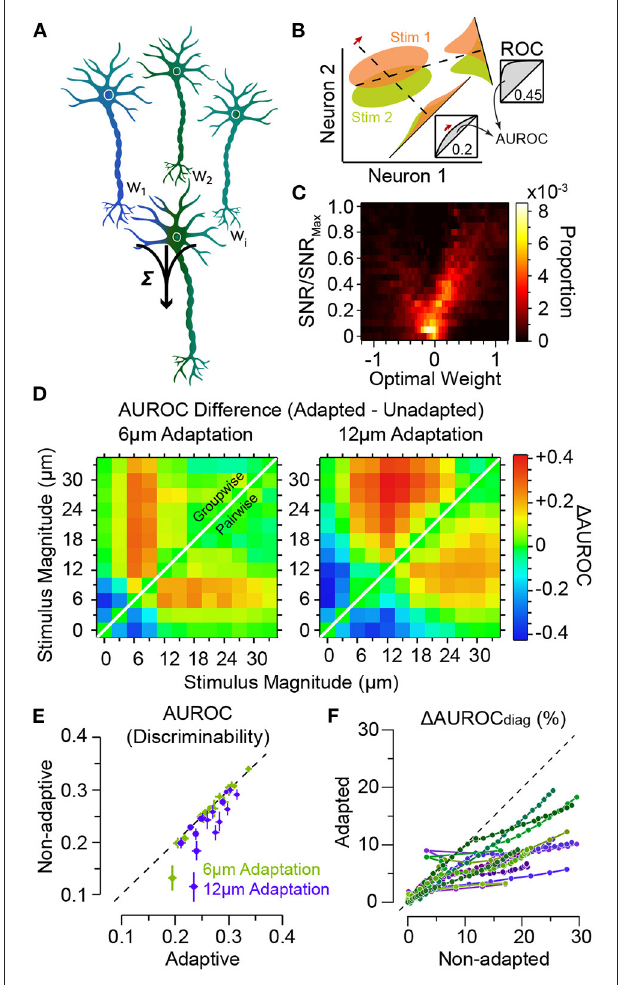
FIGURE 6 | Adaptation improves population decoding. (A) Schematic representation of linear combination of neuronal activity by the downstream decoder. Coefficients w 1 , w 2 and w i represent the synaptic weights between the neurons (top row) and the decoder (bottom). (B) Schematic representation of pooling (summation along identity line) and optimal decoding. The green and orange ovals represent the joint distribution of the neurons’ responses to two sensory stimuli. The solid black lines represent the weight vectors. The weight vector corresponding to pooling is along the identity line. The bell-shaped areas on each weight vector represent the projection of the neuronal response distribution for each stimulus on the weight vector. Dashed lines correspond to the best criterion to discriminate the two stimuli. The insets show the hit rate versus false alarm rate (ROC) for every possible criterion. Grey shaded areas indicate area under ROC (AUROC) quantifying discriminability. (C) The optimal decoding weights for informative neurons are higher. Histogram of the optimal weights as a function of the signal-to-noise ratio (SNR) for each stimulus pair across populations of 8 single neurons. The weights and SNR values are normalised to that of the best neuron in each population. (D) Shift in discriminability from low amplitudes to amplitudes higher than the adapting stimulus for every stimulus pair, in a sample session with 11 simultaneously recorded single neurons. Left and right panels exhibit the difference in discriminability (in terms of AUROC) between adapted and non-adapted conditions. Pairwise decoding applies a distinct set of weights for every stimulus pair, while the groupwise decoding applies an identical weight vector to discriminate across all stimulus pairs. (E) Decoding generalisation across